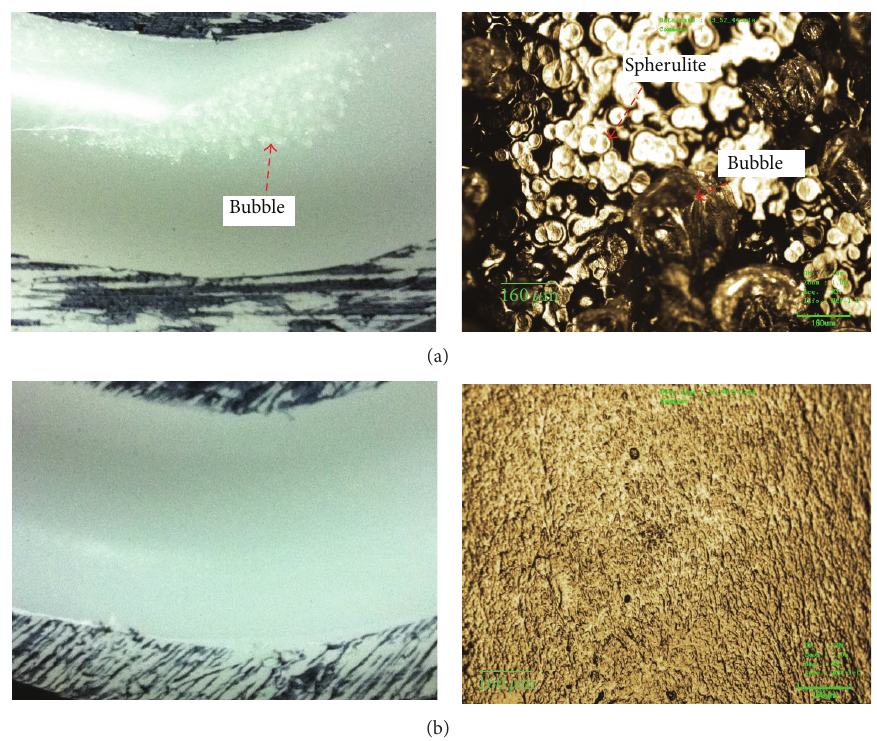
Figure 15: Images obtained by scanning confocal microscopy and the measured inner surface in (a) GAIM and (b) WAIM products.